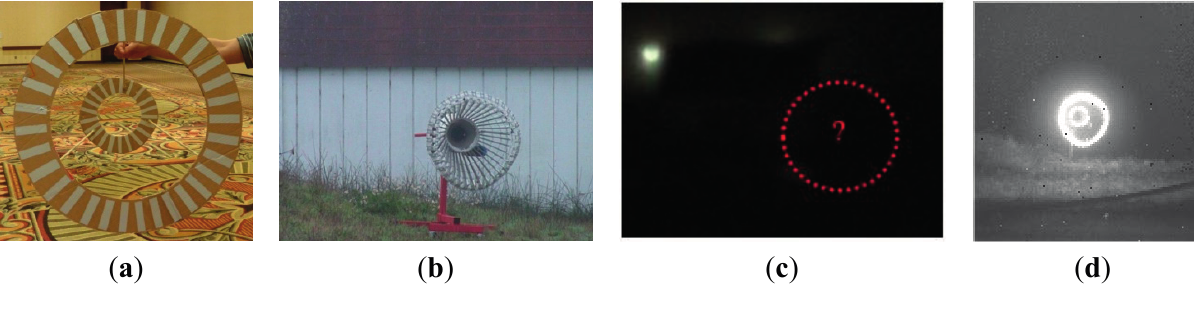
Figure 12. The full size drogue mock